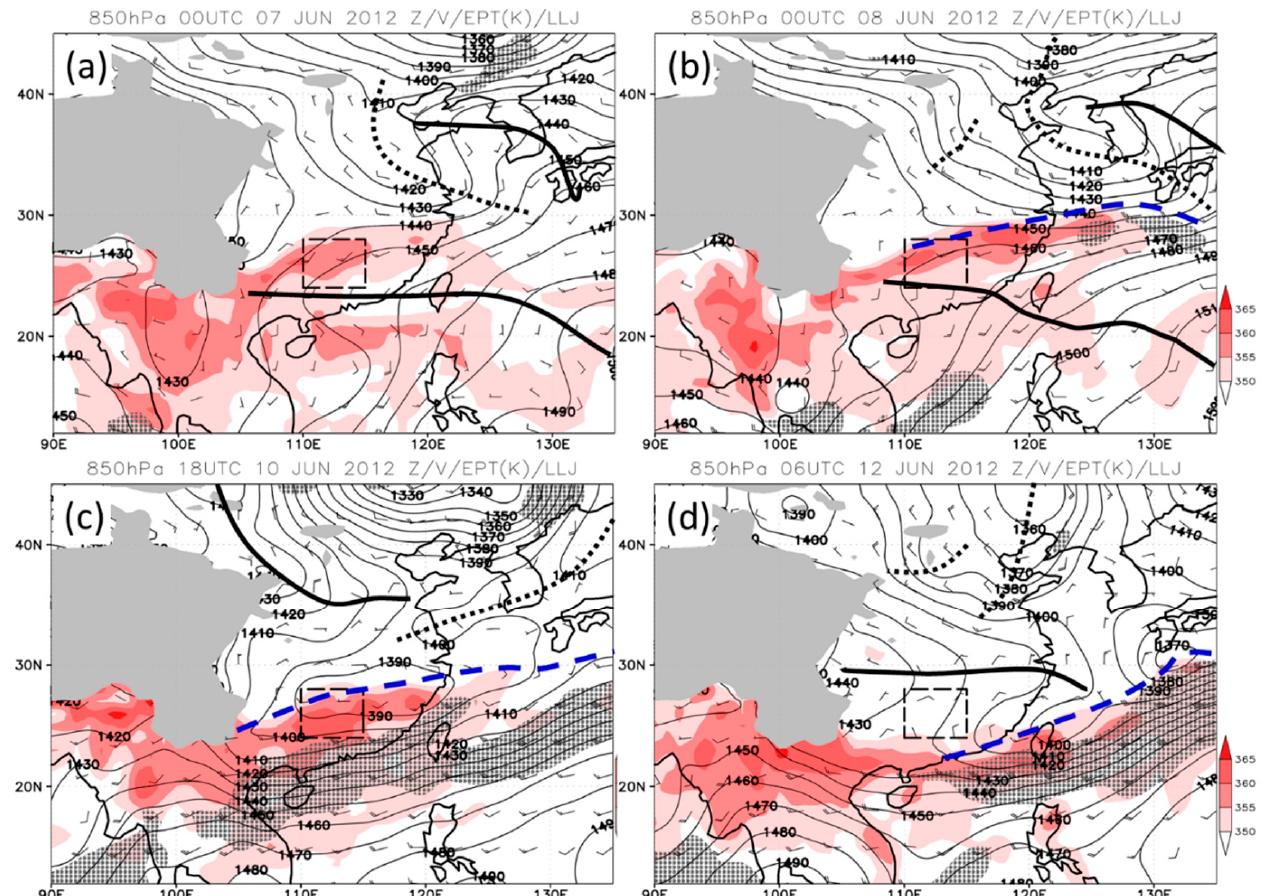
Figure 5. The geopotential height (gpm, contours, every 10 gpm), horizontal winds (barbs, full barb = 10 kt), equivalent potential temperature ( θ e , K, color), and the location of LLJ exceeding 12.5 m s − 1 (stippled) at 850 hPa at ( a ) 0000 UTC 7, ( b ) 0000 UTC 8, ( c ) 1800 UTC 10, and ( d ) 0600 UTC 12 June 2012 in the ERA-Interim analysis. The ridge (thick solid line), trough (dotted line), and surface frontal location (in JMA charts; blue dashed line) are marked. Gray shades indicate the topography higher than 1500 m, and the box for average in South China is also plotted (dashed box).